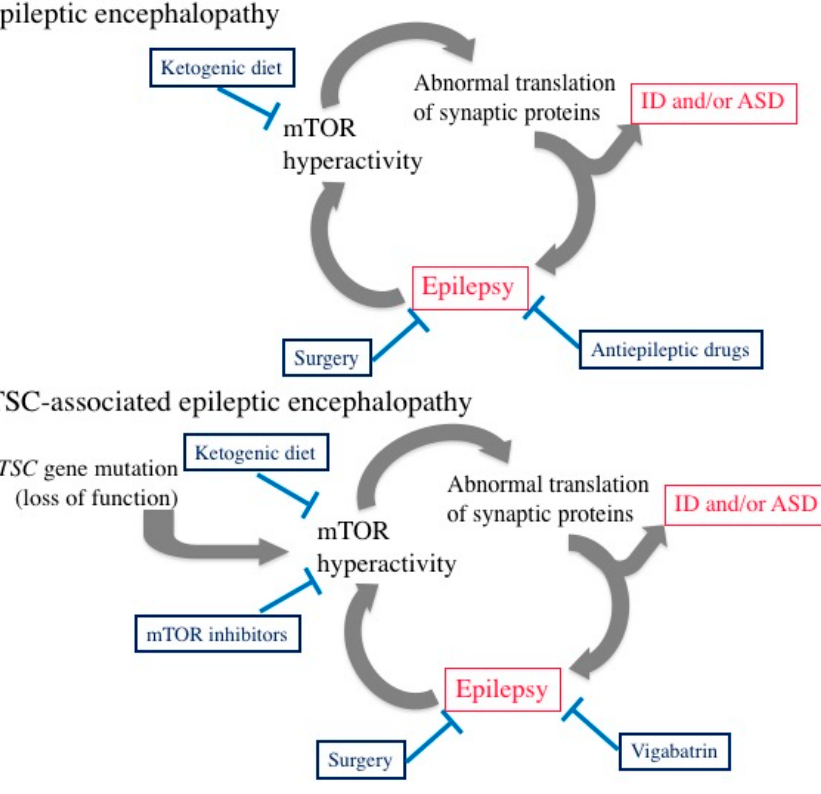
Figure 5. Vicious cycle in the brains of infants with epileptic encephalopathy of any etiology ( top ), and its association with TSC ( bottom ), showing the involvement of the mTOR pathway. Boxes with blue letters indicate therapeutic measures currently available and commonly used.